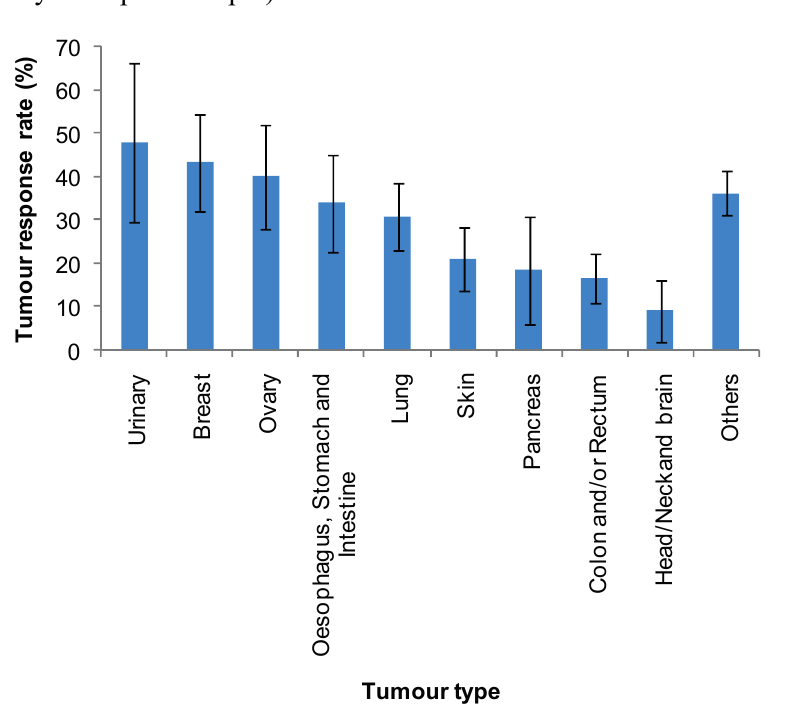
Figure 4. Graphical representation of the tumuor response rates for PDCs (release mediated both by cathepsin and